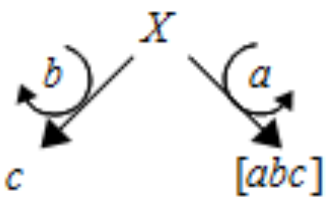
Figure 2. Ternary operation of